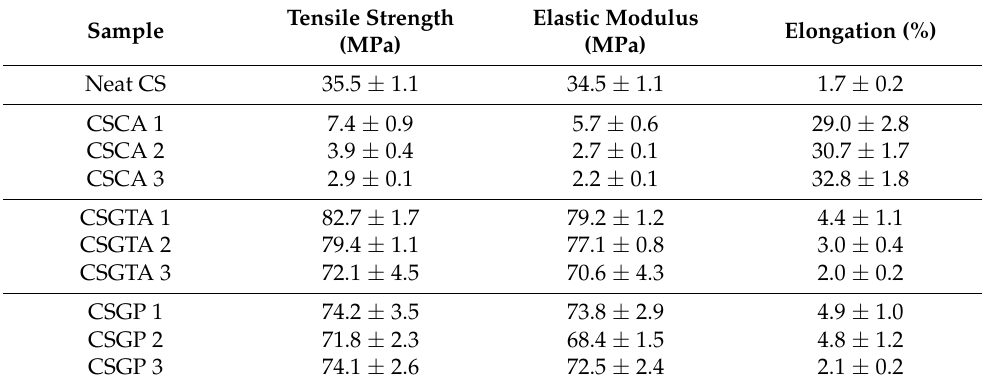
Table 3. The UTM test results of the chitosan (CS) films using a 250 N load cell. The specimens were prepared according to ASTM